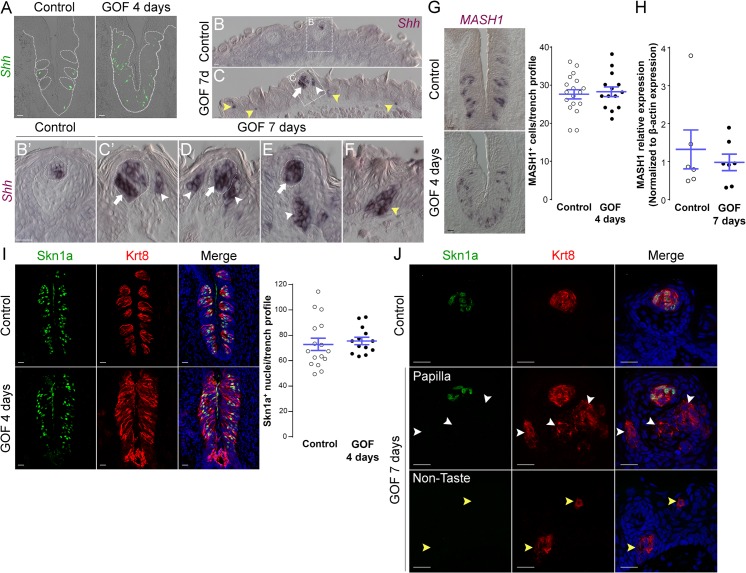
Stabilized β-catenin increases the number of Shh+ precursors of all three taste cell types, but does not impact specific precursors of Type II or III cells.
A. In control mice, 1–3 Shh+ basal cells (green) are located in the basal compartment of each taste bud section (dashed circles), whereas in the CVP of mutant mice fed dox chow for 4 days, Shh+ cells (green) are increased and widespread in the expanded taste epithelium (dashed line). B,B’. In the anterior tongue of control mice, Shh
+ cells are restricted to FFP taste buds. C-F. In stabilized β-catenin mutants following 7 days on dox, in addition to endogenous Shh
+ cells (white arrows), ectopic Shh
+ cells are detected in FFP epithelium (white arrowheads in C,C’,D,E), as well as in non-taste epithelium adjacent to filiform papillae (yellow arrowheads in C,F). MASH1 and Skn-1a are expressed in subsets of basal cells within taste buds, and regulate the Type III and Type II cell lineage, respectively. CVP sections of control and mutant mice after 4 days on dox showed that Mash1
+ (G) and (I) Skn-1a+ (green) cell numbers were not altered by β-catenin stabilization. Real-time RT-PCR on the anterior tongue epithelium showed no difference in the expression of MASH1 between controls and mutants (H). J. After 7 days on dox chow, Skn-1a+ cells (green) were restricted to endogenous FFP taste buds in control and mutant mice (Krt8+ red, arrow). In mutants, Skn-1a+ cells were not detected in ectopic Krt8+ clusters in FFP epithelium (J, white arrowheads) or non-taste epithelium (J, yellow arrowheads). Nuclei were counterstained with DRAQ5 in blue. Dotted line indicates the basement membrane, and dashed circles indicate taste buds. Representative stack images and data from 3 control and 3 mutant mice. Data are represented as a scatter plot (individual symbols), and mean ± SEM (blue bars). Student’s t-test. Scale bars = 20 μm.